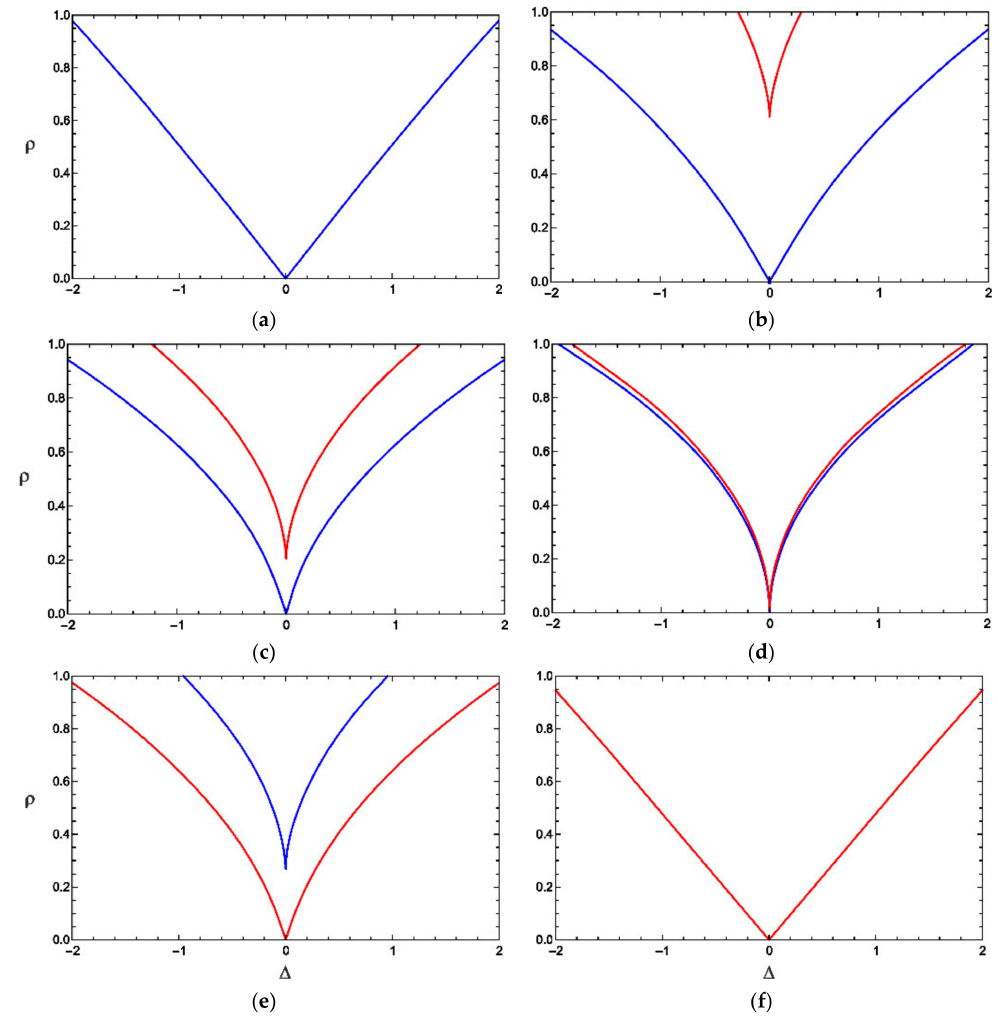
Figure 3. Boundaries of in-phase (blue curves) and anti-phase (red curves) locking calculated at I 0 = 0.06, µ = 15.0, ∆ H = 0.534, and ψ = 0.4 π ( a ), 0.5 π ( b ), 0.6 π ( c ), 0.7 π ( d ), 0.8 π ( e ), and 1.0 π ( f